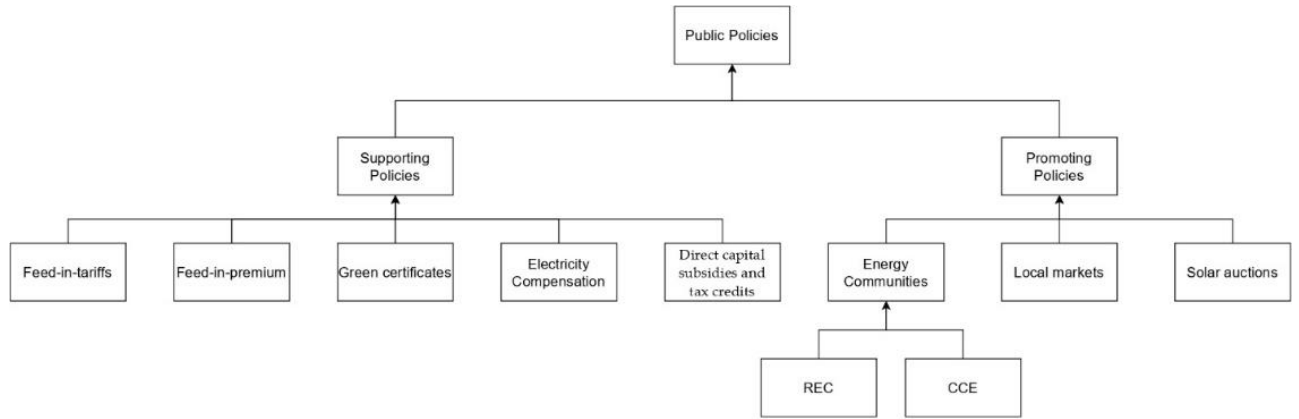
Figure 1. Diagram of supporting and promoting policies. REC — Renewable Energy Community; CCE — Citizens Community for Energy.